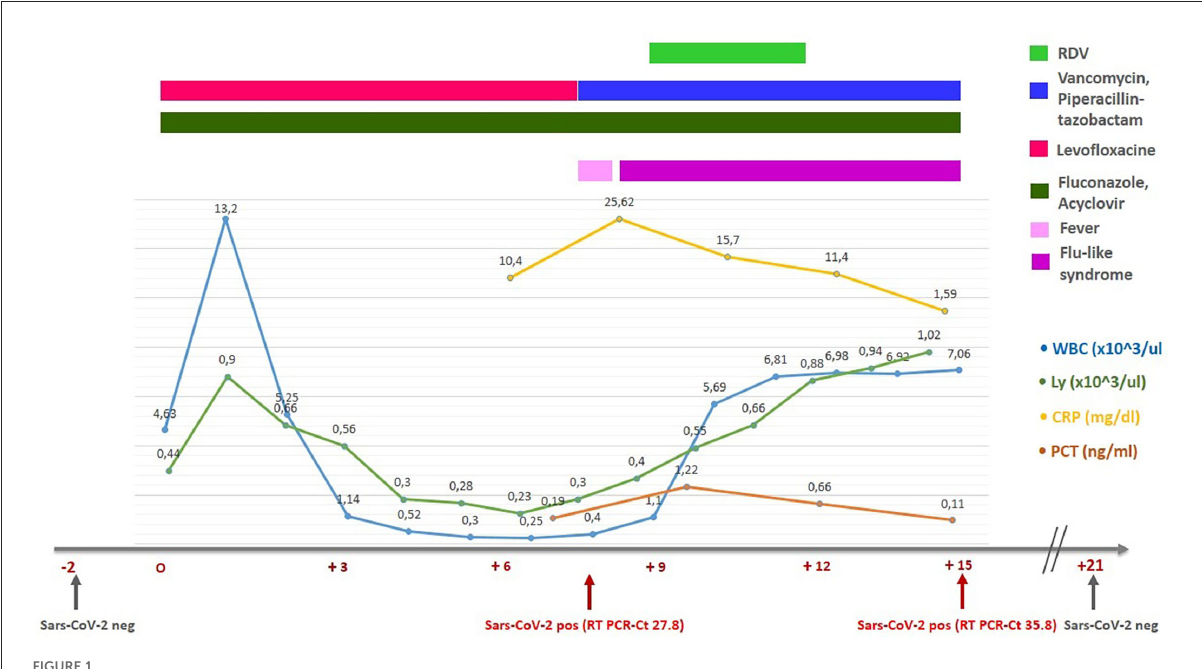
FIGURE1 Clinical outcome in patient during SARS-CoV-2